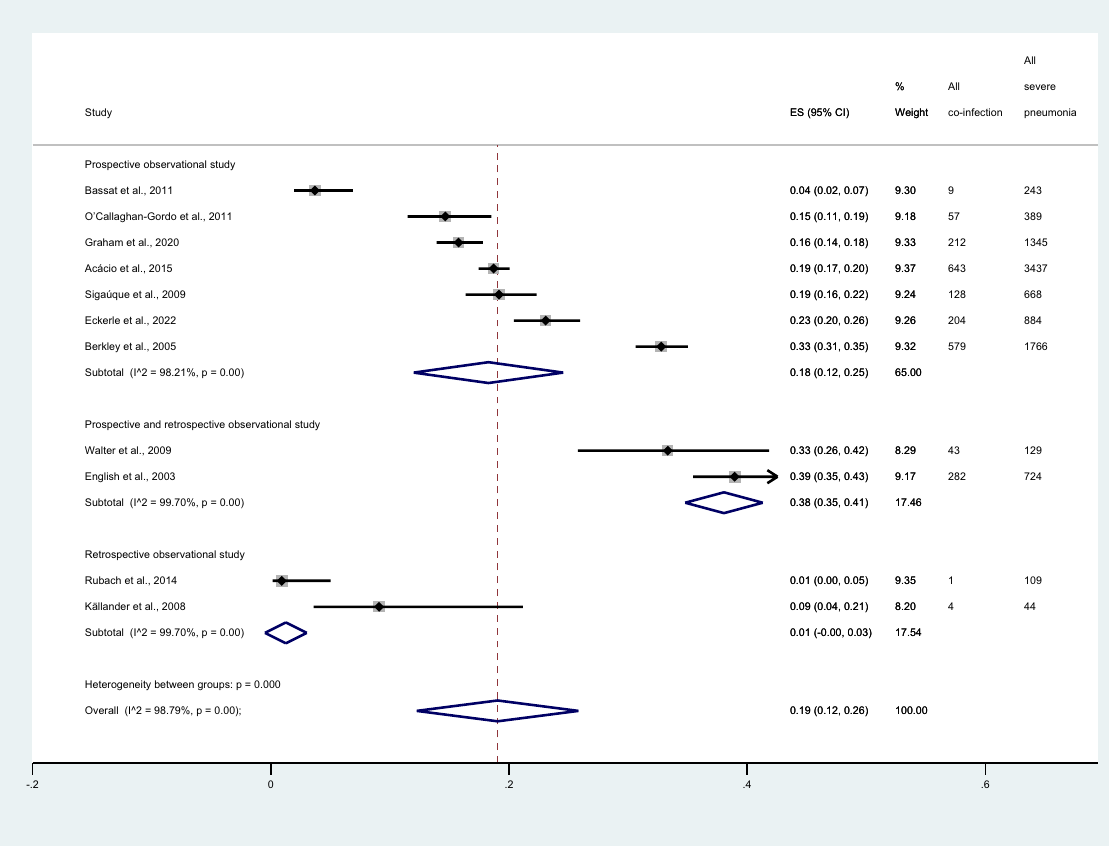
Figure 4. Forest plot demonstrates the pooled proportion of malaria among patients with severe pneumonia sub grouped by study designs. ES, proportion estimate; CI, confidence